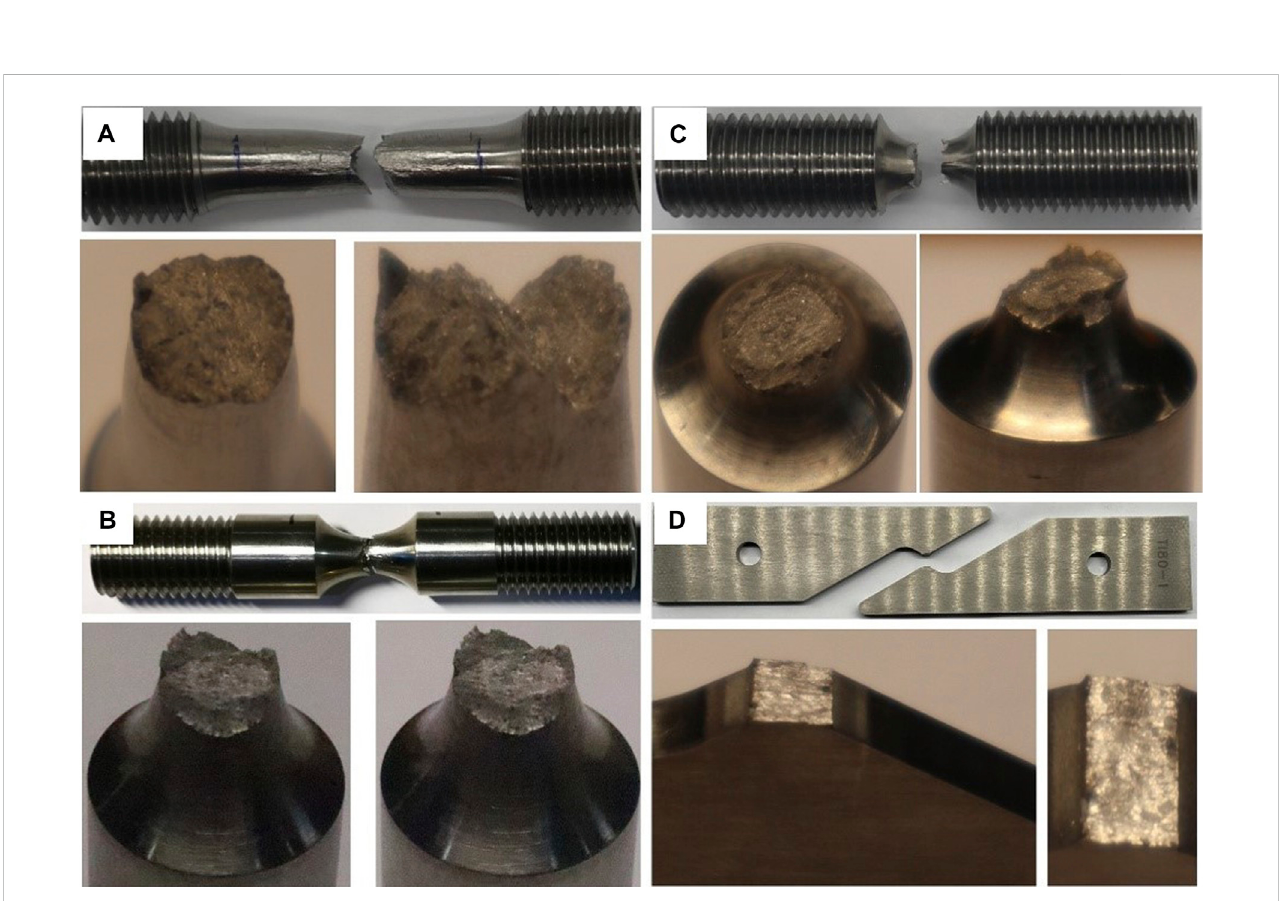
FIGURE 3 The fracture surfaces: (A) smooth round bar, (B) notched round bar, R = 10 mm, (C) notched round bar, R = 5 mm, (D) shear-induced specimen.